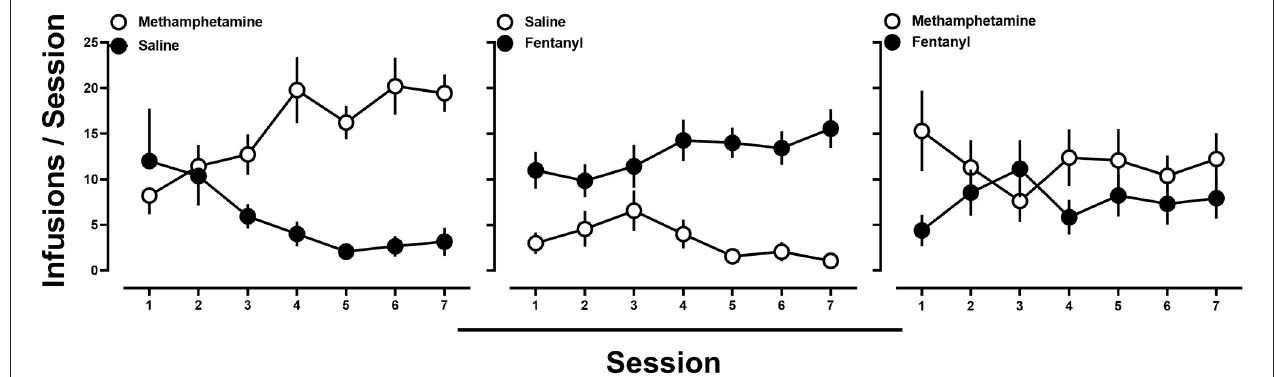
FIGURE 2 | (Left) Average number of infusions of 0.1 mg/kg/infusion methamphetamine (open circles) and saline (filled circles) when methamphetamine and saline were concurrently available. (Middle) Average number of infusions of 0.0032 mg/kg/infusion fentanyl (filled circles) and saline (open circles) when fentanyl and saline were concurrently available. (Right) Average number of infusions of 0.1 mg/kg/infusion of methamphetamine (open circles) and 0.0032 mg/kg/infusion of fentanyl (filled circles) when methamphetamine and fentanyl were concurrently available. Data represent the mean ± S.E.M., and each point represents 14–15 rats.